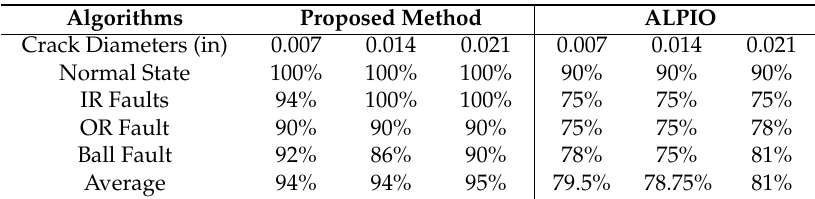
Table 6. Fault diagnosis results for Dataset 4 for the proposed method and ALPIO when torque load = 3 hp.